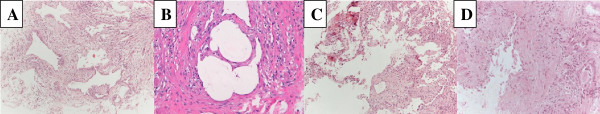
Transbronchial biopsies in three different patients with a final diagnosis of UIP.A) An area of scarring/honeycombing at the left, showing architectural abnormal lung with fibrosis and enlarged airspaces bordered by bronchiolar epithelium. Mucostasis is frequently present but can be absent, like here. Hematoxylin-Eosin, 100X. B) Higher magnification showing enlarged airspaces with bronchial metaplasia in the absence of mucus. Hematoxylin-Eosin, 20X. C) An area of fibrosis with a patchy character, in which collagen-type interstitial fibrosis is present adjacent to relatively normal alveoli. Hematoxylin-Eosin, 100X. D) A fibroblast focus, consisting in a small, dome-shaped collection of myofibroblasts within myxoid stroma, adjacent to fibrotic lung tissue. Fibroblast foci are frequently covered by hyperplastic pneumocytes, like here. Hematoxylin-Eosin, 200X.